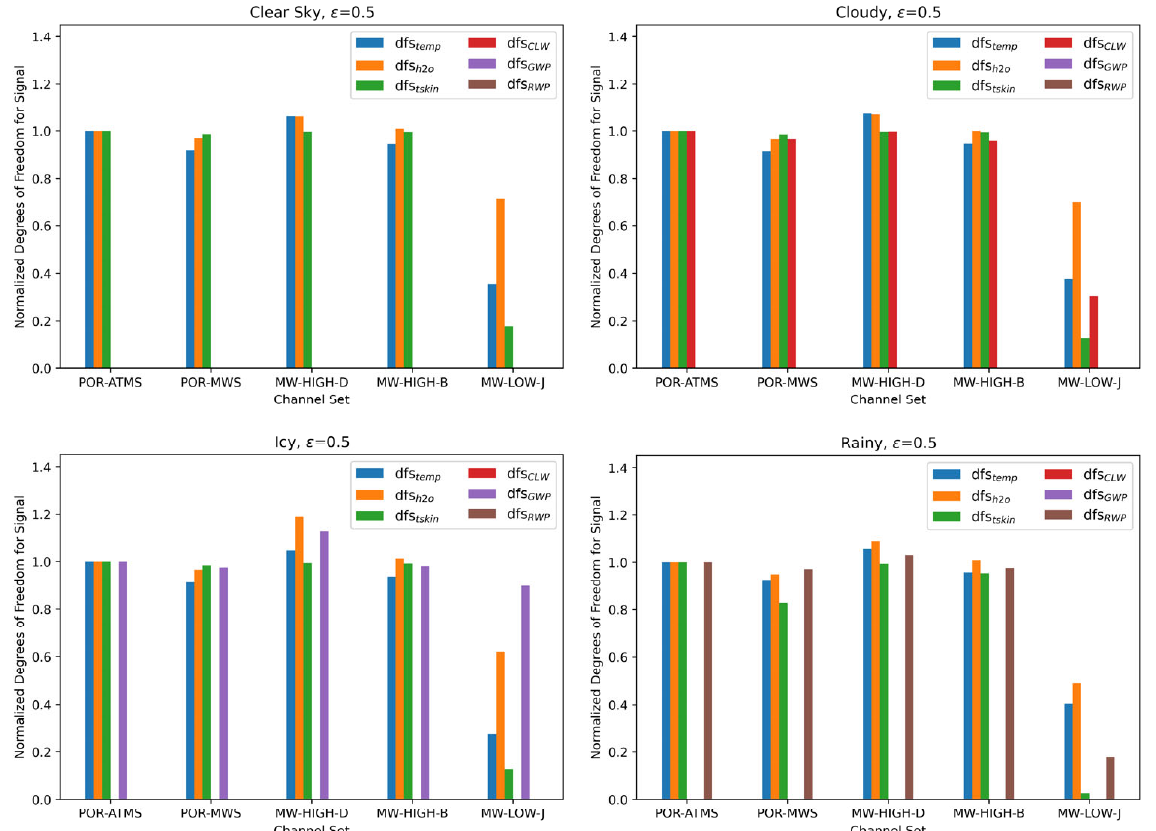
Figure 2. MW sounder temperature ( dfs temp ), water ( dfs H2O ), surface ( dfs tskin ), and cloud parameter ( dfs CLW , dfs GWP , dfs RWP ) retrieval resolution (degrees of freedom for signal) computed for emissivity = 0.5 (clockwise from top left ) and for clear, cloudy, icy (graupel), and rainy atmospheric conditions. All information content parameters computed were averaged over all atmospheres (USSTD, US Tropical, US MLS) and normalized to the program for recording ATMS values for each atmospheric condition and emissivity. In the legend, CLW, GWP, and RWP correspond to total column cloud liquid water, graupel water path, and rain water path.